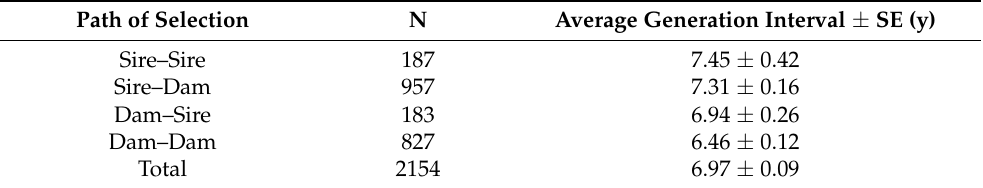
Table 1. Average generation intervals ( ± SE) computed for the four selection paths in Tropical Milking Criollo cattle.